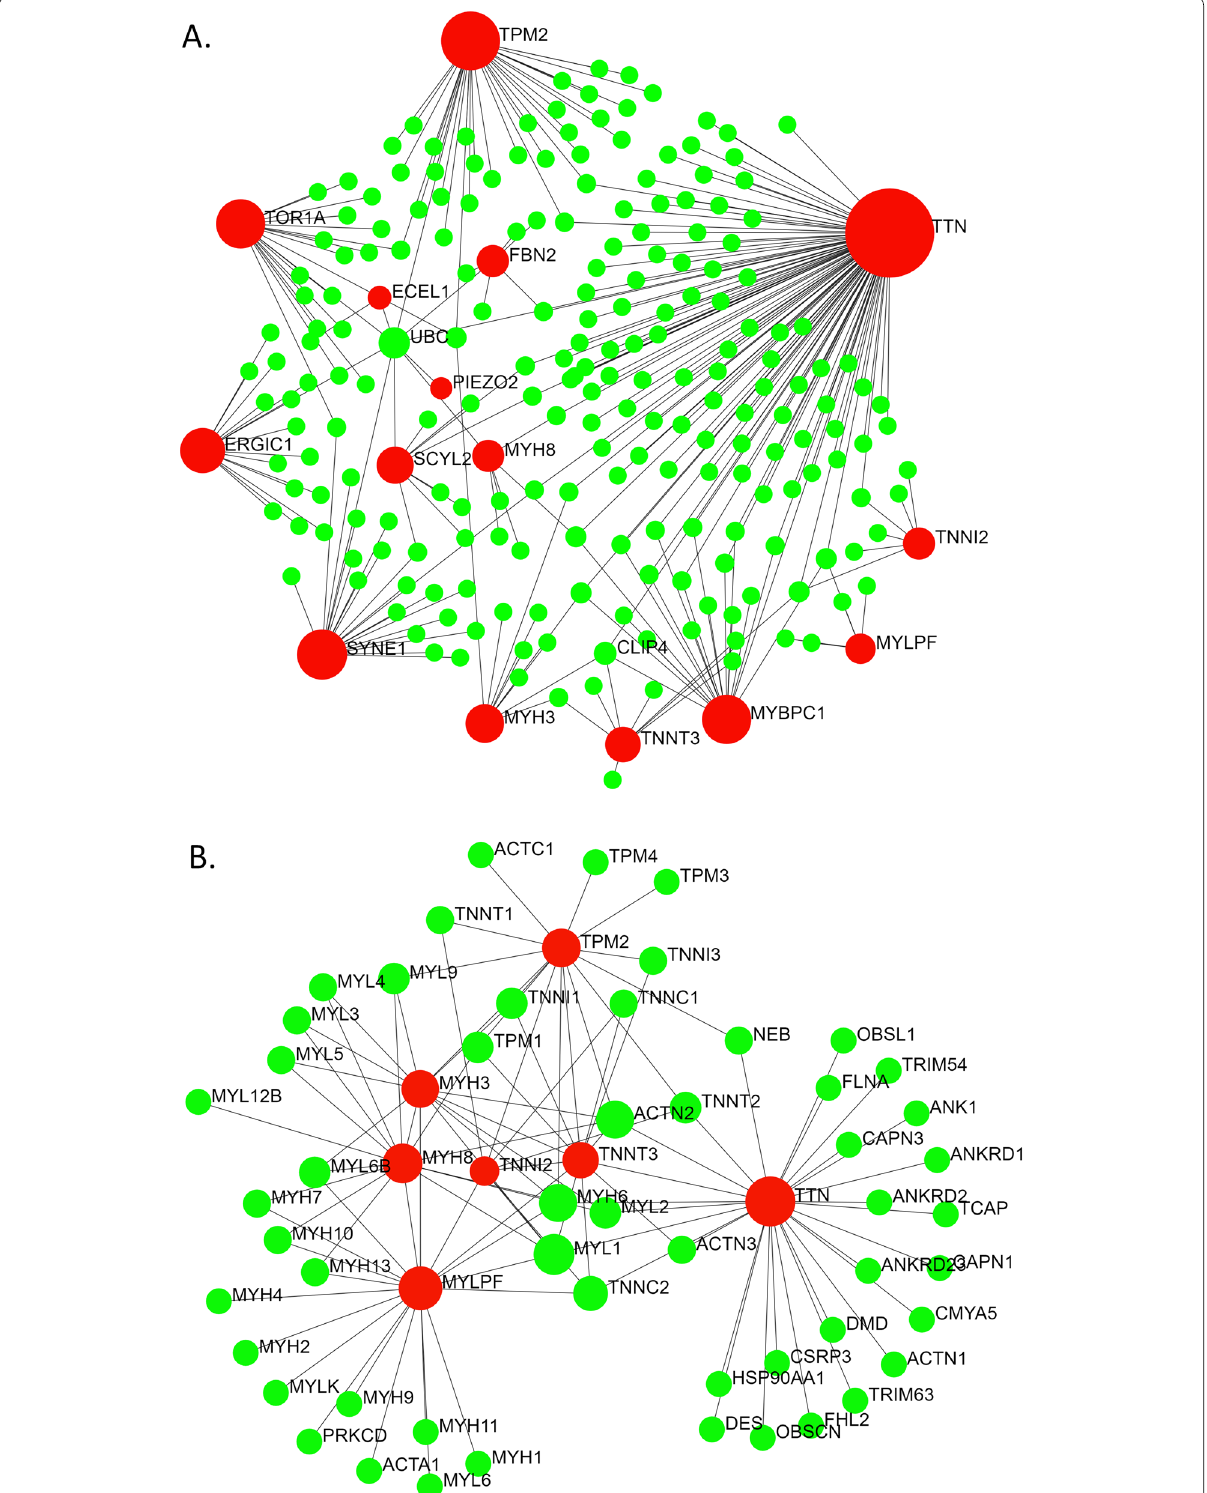
Fig. 3 PPI networks generated using the genes along with 15 known genes associated with AMCs and DAs based on ( A ) IMEx and ( B ) STRING interactome databases through NetworkAnalyst. AMC and DA-associated gene-encoded proteins along with TTN are shown in red and the other interacting proteins are shown in